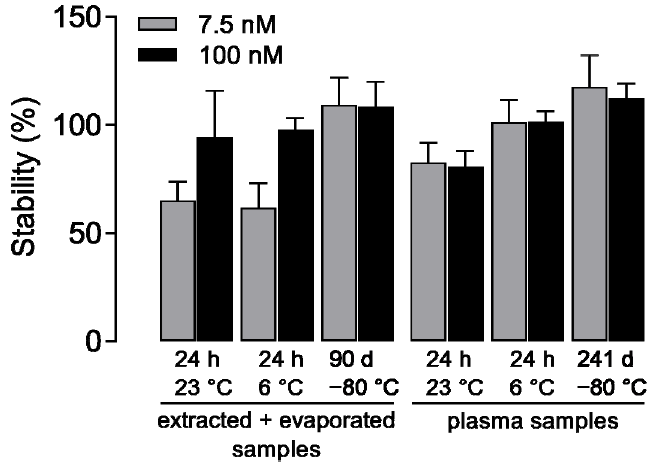
Figure 4. Stability of PDA-66 as a function of time and temperature of storage, relative to controls freshly extracted and co-determined on the day of measurement (set to 100%). The ratio of the m/z values of the quantifiers m/z 317.1 (PDA-66) and m/z 250.1 (internal standard) was determined. Shown are the mean values ± SD of n = 8 (90 days, − 80 °C extracted and evaporated samples) and n = 4 (remaining analysed samples) independent LC-MS/MS runs.